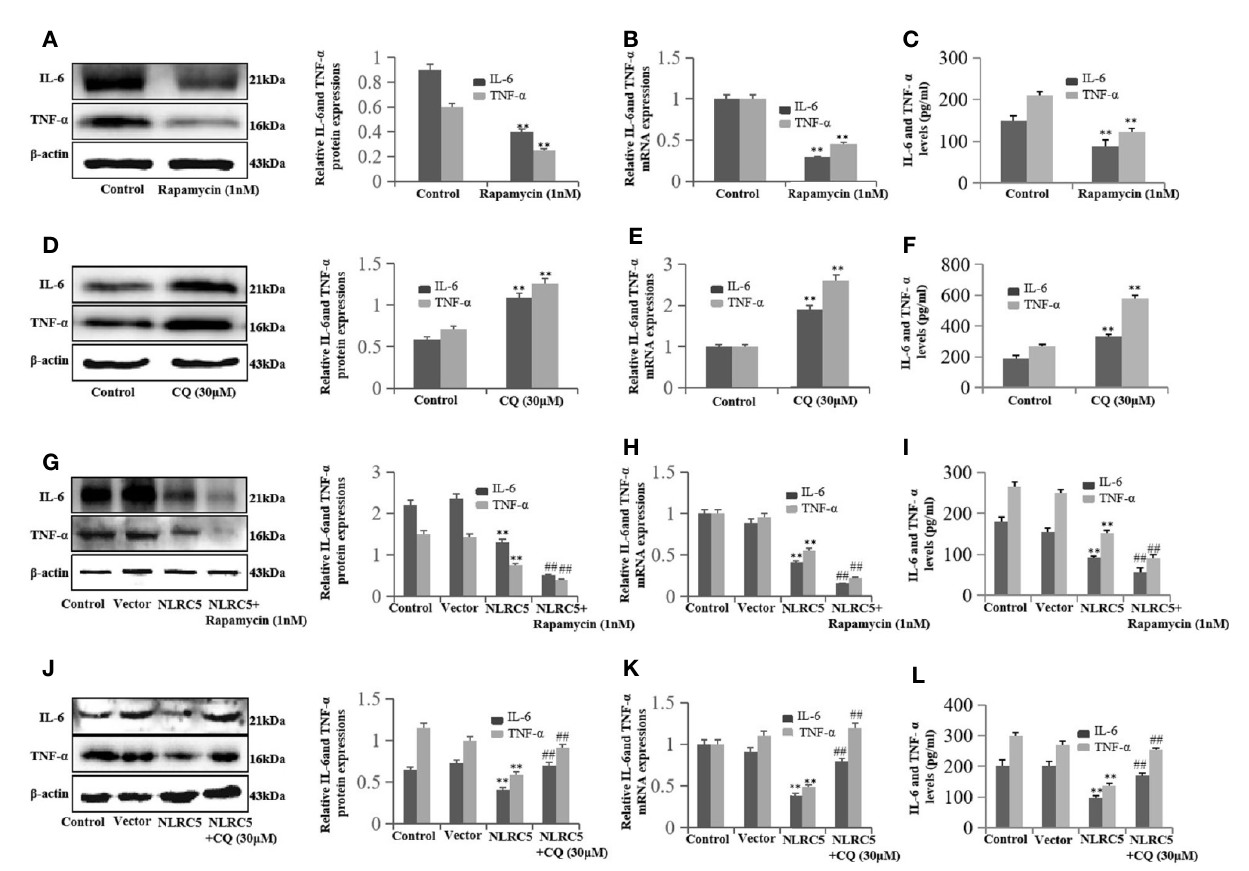
FIGURE 6 | NLRC5 inhibits in fl ammation in EESCs by promoting autophagy (n = 9). (A – C) Representative western blotting, qRT-PCR, and ELISA showing promotion of autophagy by using 1 nM autophagy agonist rapamycin signi fi cantly inhibited IL-6 and TNF- a expression when compared with control group (**P < 0.01 vs. control group). (D – F) Representative western blotting, qRT-PCR, and ELISA showing inhibition of autophagy by using 30 m M autophagy inhibitor CQ signi fi cantly promoted IL-6 and TNF- a expression when compared with control group (**P < 0.01 vs. control group). (G – I) Representative western blotting, qRT- PCR, and ELISA showing promotion of autophagy by 1 nM rapamycin contributed to the NLRC5-mediated inhibition of IL-6 and TNF- a expression in EESCs (**P < 0.01 vs. vector group and ## P < 0.01 vs. NLRC5 group). (G) Representative western blotting, qRT-PCR, and ELISA showing inhibited autophagy by 30 m M CQ restricted the NLRC5-mediated inhibition of IL-6 and TNF- a expression in EESCs (**P < 0.01 vs. vector group and ## P < 0.01 vs. NLRC5 group). The expression levels of mRNA were normalized with respect to b -actin and were calculated using the 2 - DD Ct method. The protein expression levels were quanti fi ed by Image J software and normalized to b -actin protein levels. The results are represented as the mean ± SEM from at least three independent